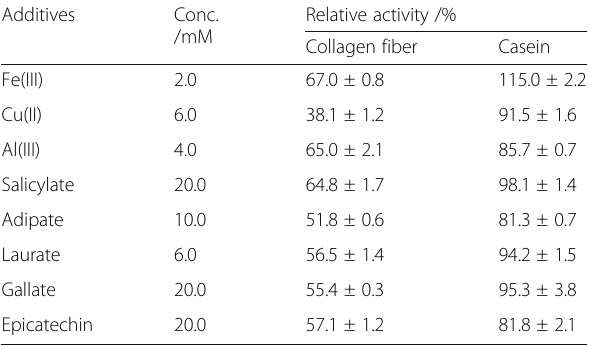
Table 1 The effect of the additives on the hydrolytic activity of proteinase K